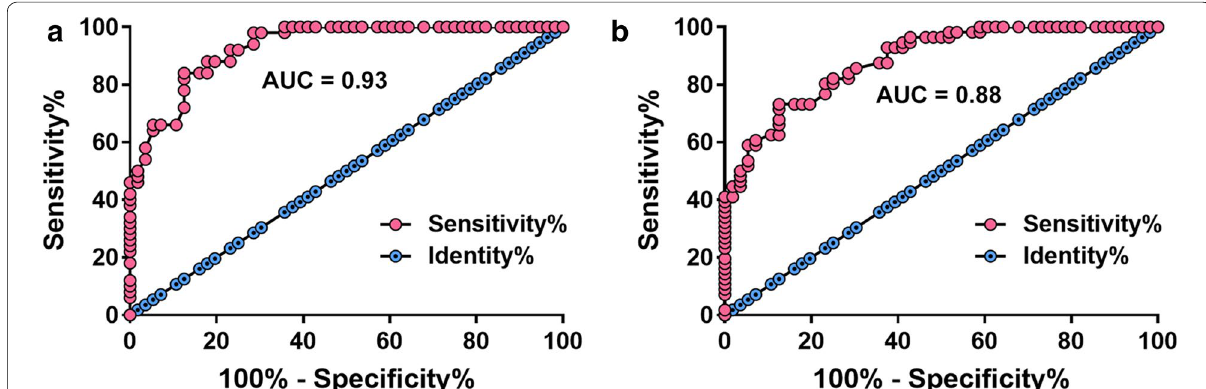
Fig. 2 High expression levels of NCK1-AS1 distinguished OSCC patients from OU patients and healthy participants. ROC curve analysis was performed with the 55 early-stage OSCC patients as true positive cases and OU patients or healthy participants as true negative cases. It was